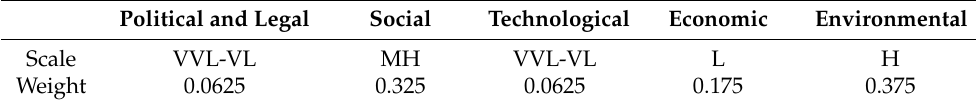
Table 16. The scale of criterion weights in the TOPSIS method. 0.005—very very low (VVL); 0.125—very low (VL); 0.175—low (L); 0.225—medium low (ML); 0.275—medium (M); 0.325—medium high (MH); 0.375—high (H); 0.425—very high (VH); 0.475—very very high (VVH). Political and